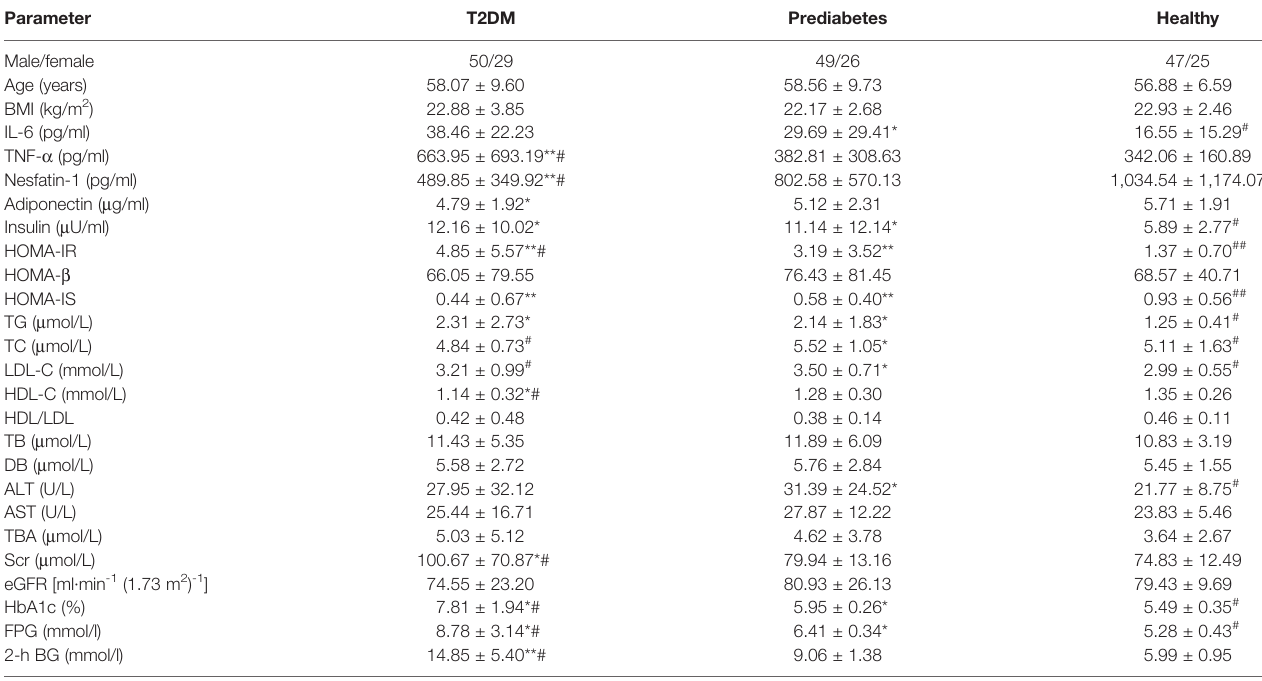
TABLE 1 | Anthropometric and clinical characteristics of the study subjects in different groups. Parameter T2DM Prediabetes